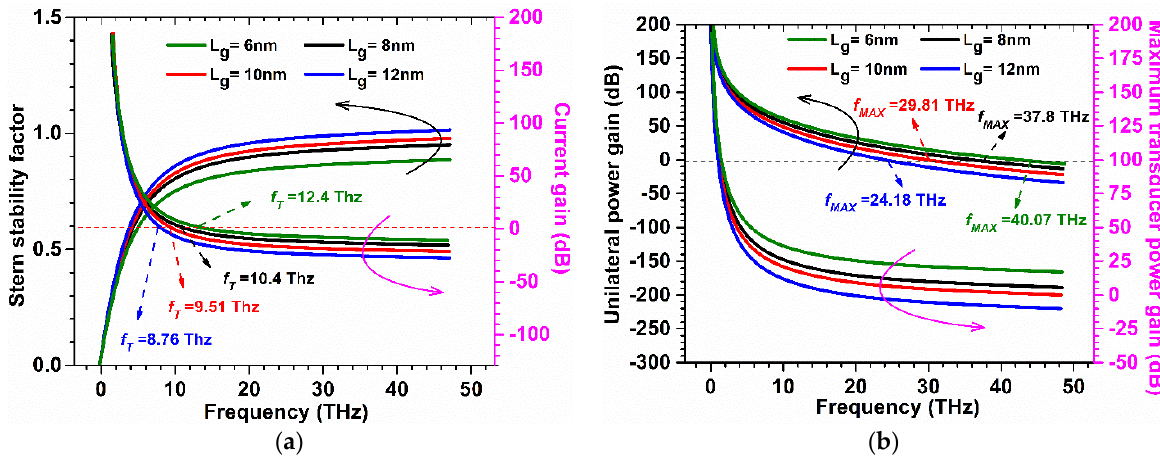
Figure 11. ( a ) SS and Current Gain at various gate lengths of GaN-SOI-FinFET. ( b ) Unilateral Power Gain and G MT at various gate lengths of GaN-SOI-FinFET.